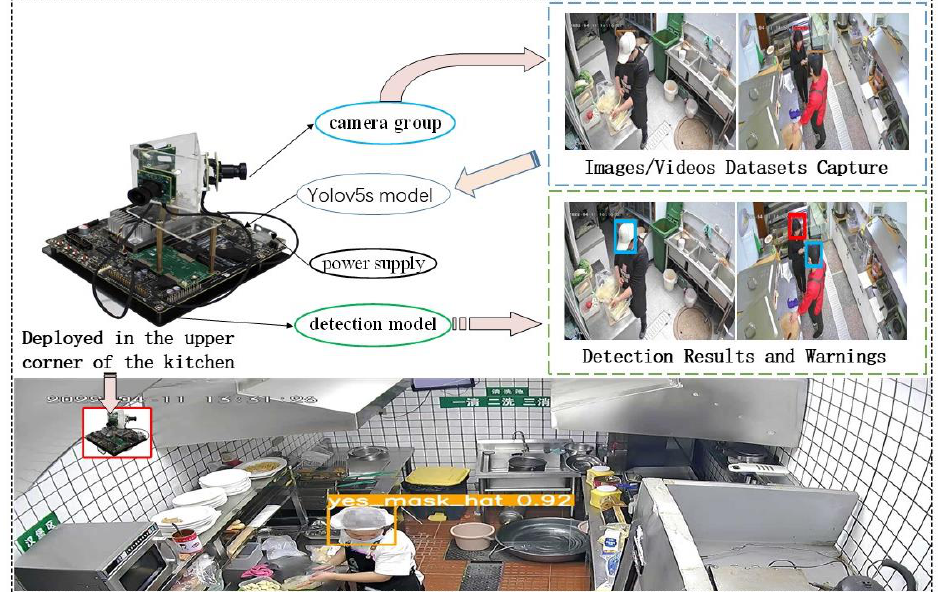
Figure 3. The process of deploying a standard dress detection system to a kitchen. According to the processing process, the proposed detection method for kitchen standard dress detection includes three stages, as shown in Figure